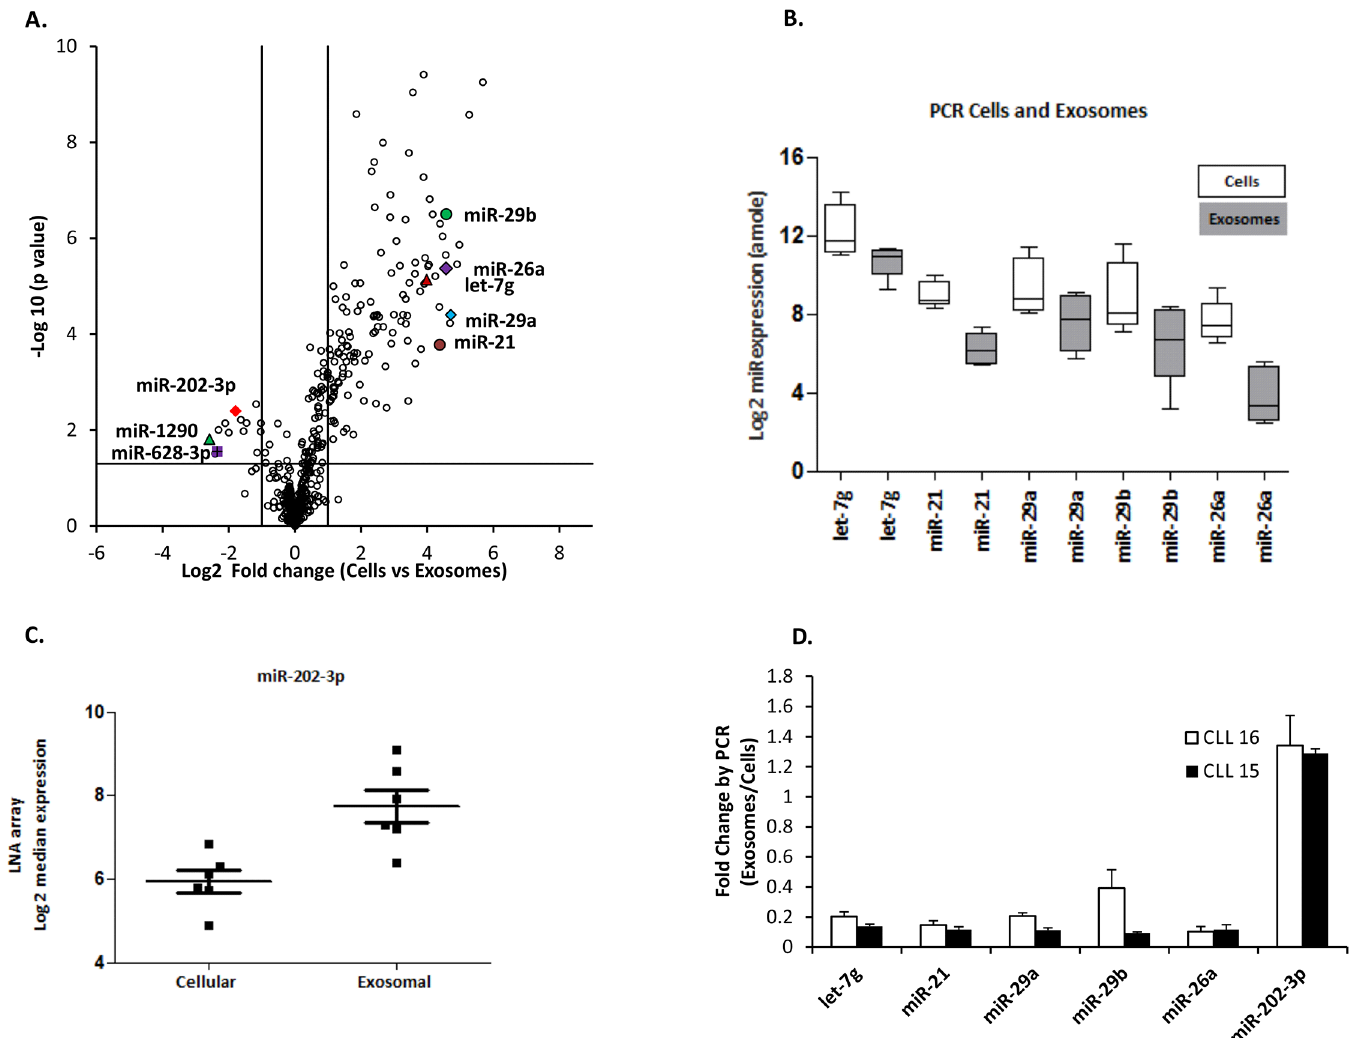
Fig 4. MicroRNA profiles and RT-qPCR of purified exosomes and parental CLL cells. A) A volcano plot of LNA array miRNA profiles of CLL cells vs exosomes samples is depicted. The x-axis shows the Log2 fold-change in miRNA expression between cellular cases and exosomes. The y-axis shows the -Log10 of the p value for each miRNA. Expressed miRs that are statistically significant between the two groups appear above the line (p < 0.05). B) The miRs let-7g, miR-21, miR-29a, miR-29b, and miR-26a were selected for validation of LNA array by RT-qPCR analysis (n = 5). Data represent mean ± S.E.M of triplicate experiments. C) miR-202-3p is enriched in exosomes compared to parental cells in the LNA array data (mean ± S.E.M). D) Fold change of miR expression in exosomes vs cellular CLL samples showing the enrichment of miR-202 by RT-qPCR in two representative